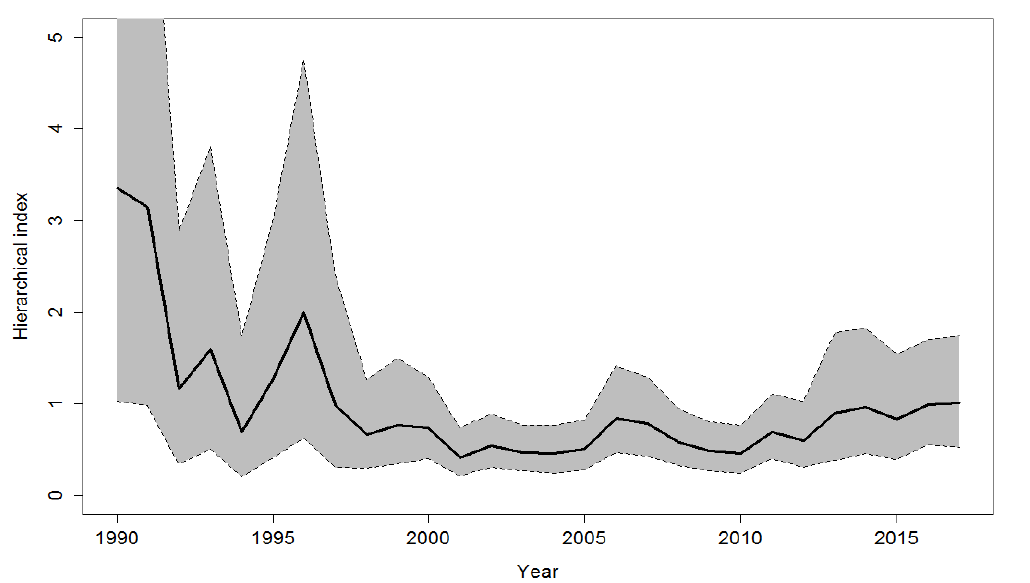
Figure 81. Time series of male horseshoe crab relative abundance in the Delaware Bay region as estimated from the hierarchical analysis. The black line gives the posterior mean and the grey, shaded area represents a 95% credible interval about the time series.